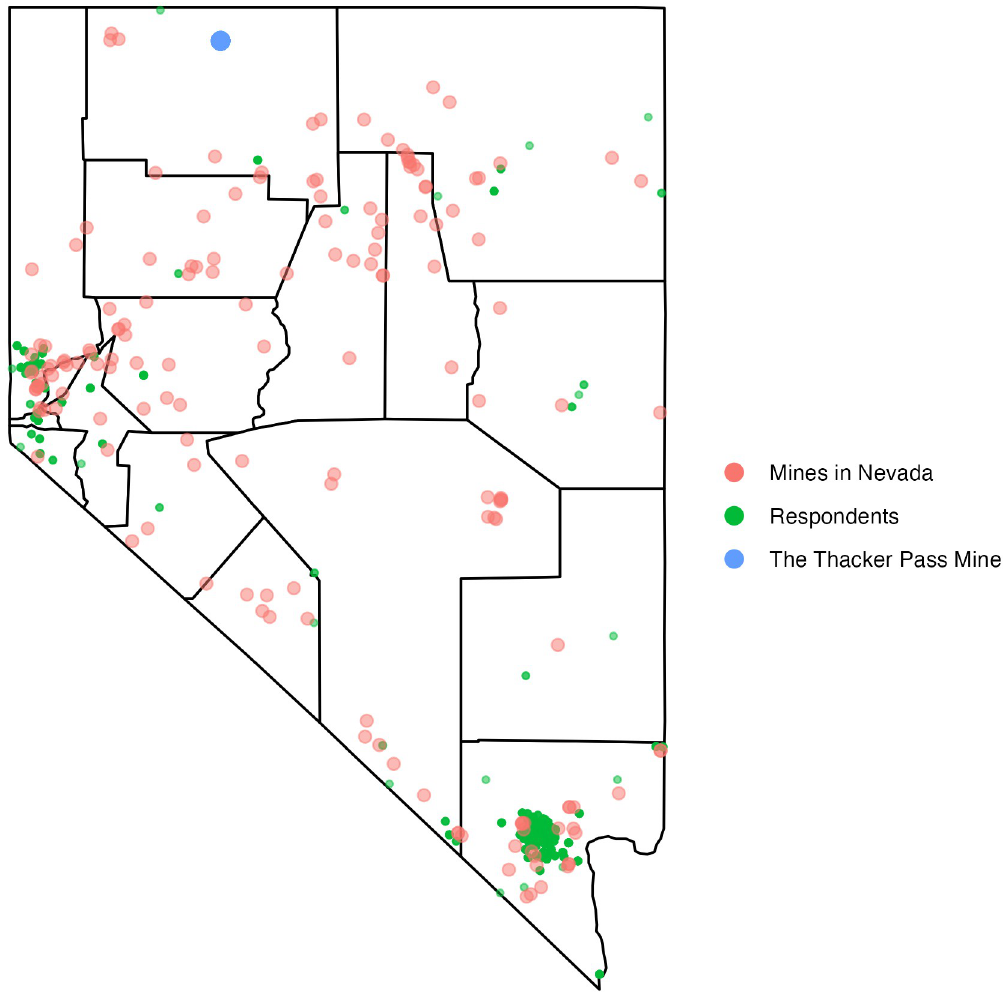
Fig 1. The location of the proposed Thacker Pass lithium mine, existing mines, and